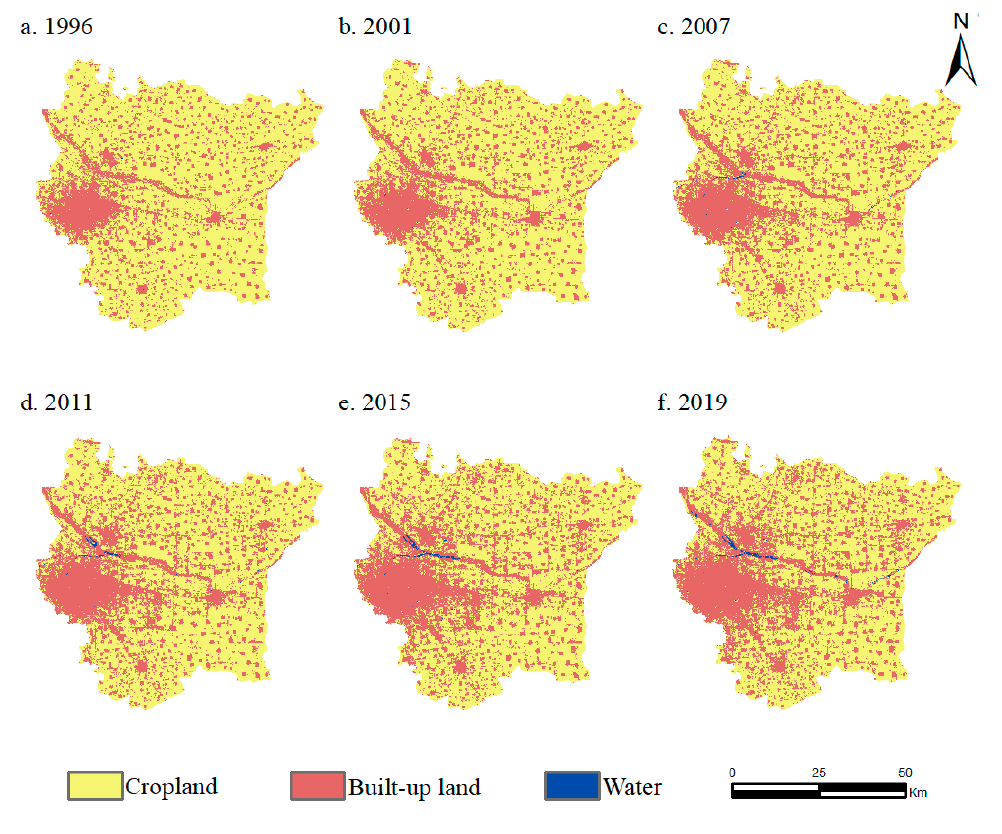
Figure 2. Land-use distribution in the study area from 1996 to